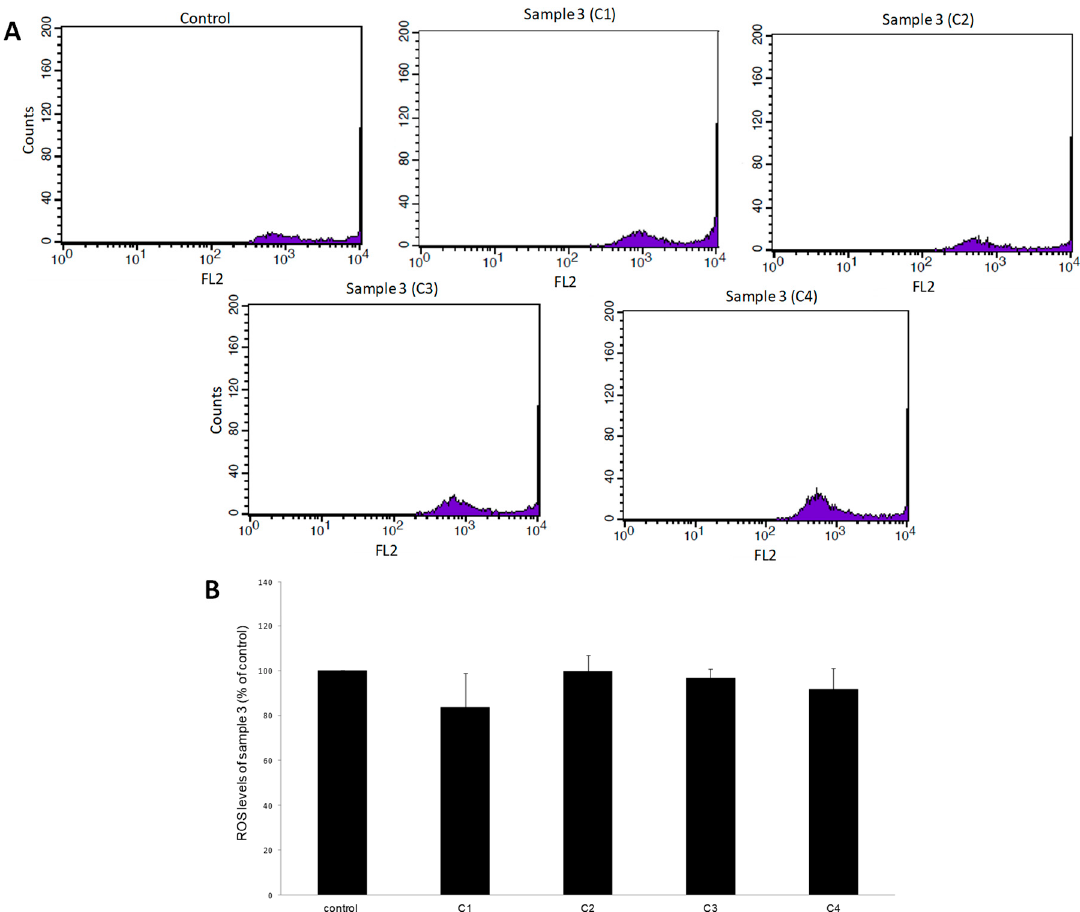
Figure 4. The effects of sample 3 on reactive oxygen species (ROS) levels in EA.hy926 cells after treatment for 24 h, as assessed by flow cytometry. ( A ) The histograms of cell counts versus fluorescence of 10,000 cells after treatment with sample 3. ( B ) Bar charts demonstrate the ROS levels as % of control as estimated by the histograms in EA.hy926 cells after treatment. C1, C2, C3, C4: 200, 400, 800, and 1600 μ g/mL, respectively. * Statistically significant compared to the control cells. FL2: The detection of fluorescence using 488 and 580 nm as the excitation and emission wavelength, respectively.